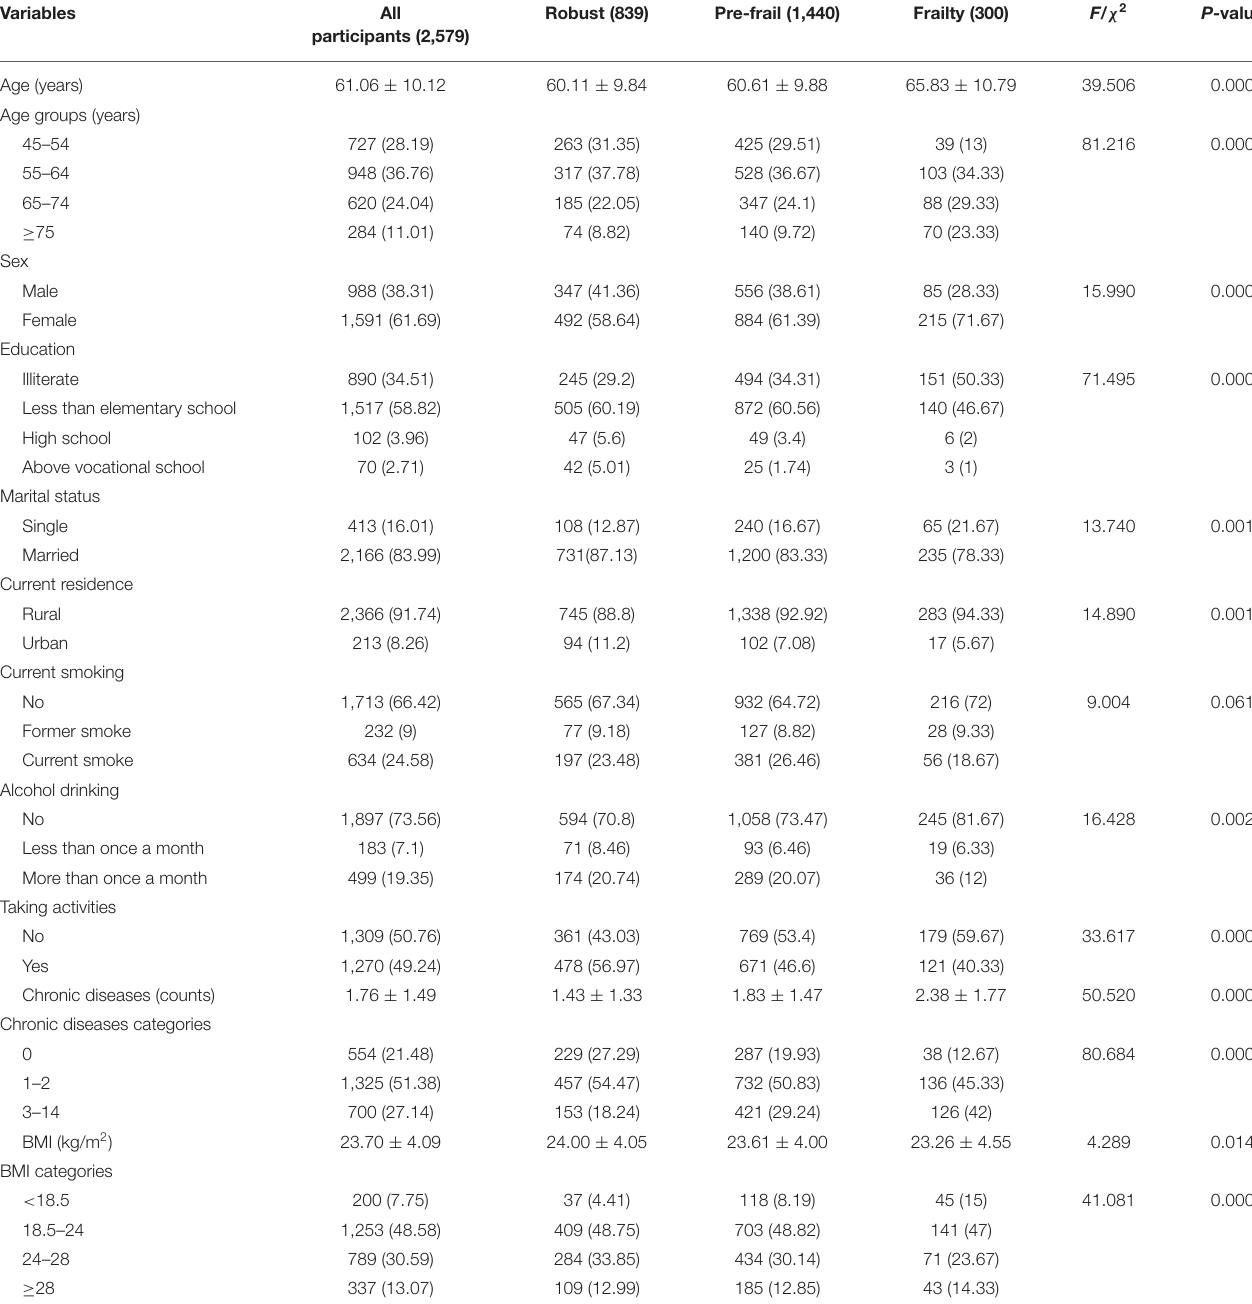
TABLE 2 | Baseline characteristics of participants according to the level of frailty in CHARLS Waves2011.